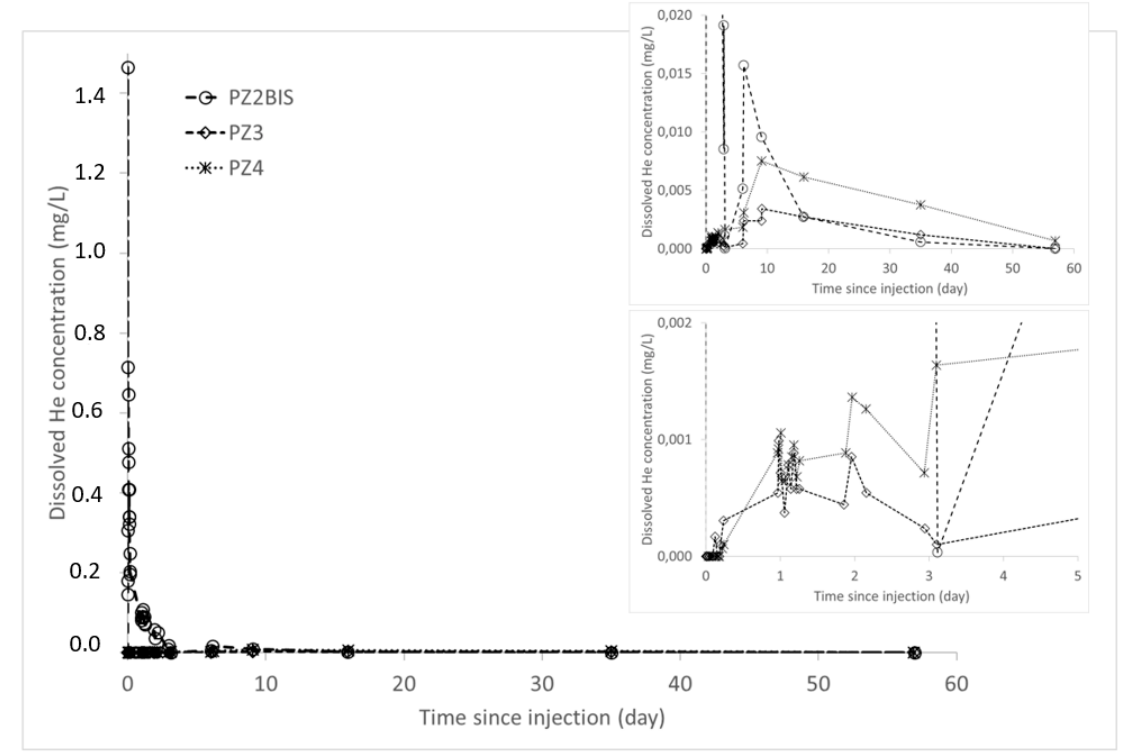
Figure 12. Dissolved helium concentrations in the samples taken at the downstream piezometers PZ2BIS, PZ3, and PZ4.